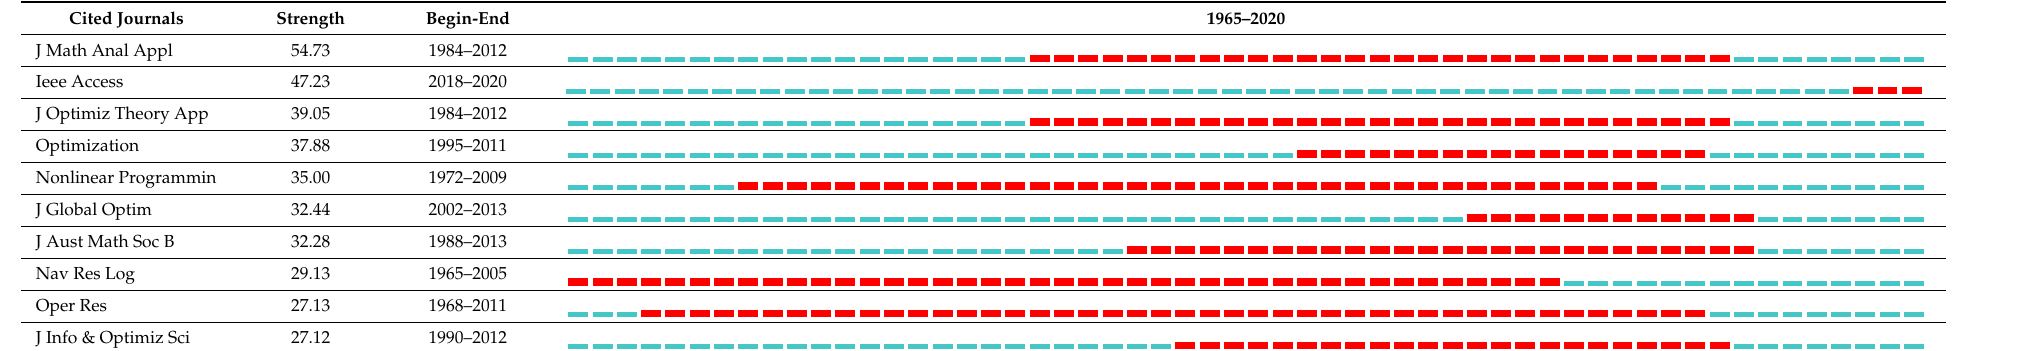
Table 7. Top 10 cited journals with the strongest citation bursts. The last column includes blue and red lines where the blue line portrays the beginning and end of a cited journal through the years and the red line illustrates the period of a cited authors